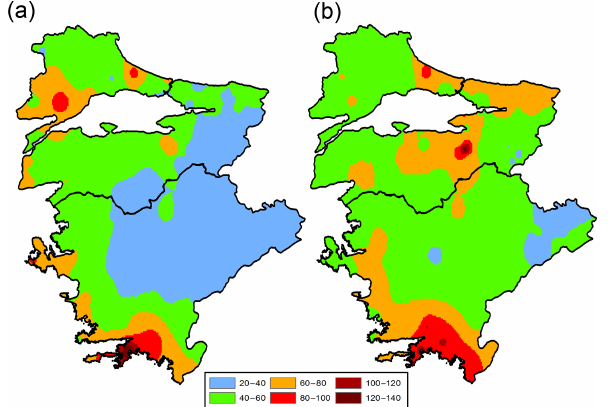
Figure 3. (a) The map shows the threshold values (in mm) of the stations during 2006–2015 when precipitation exceeded the 90th percentile generating an EPE. (b) The contribution of the total EP of a station to its annual mean precipitation (mm).